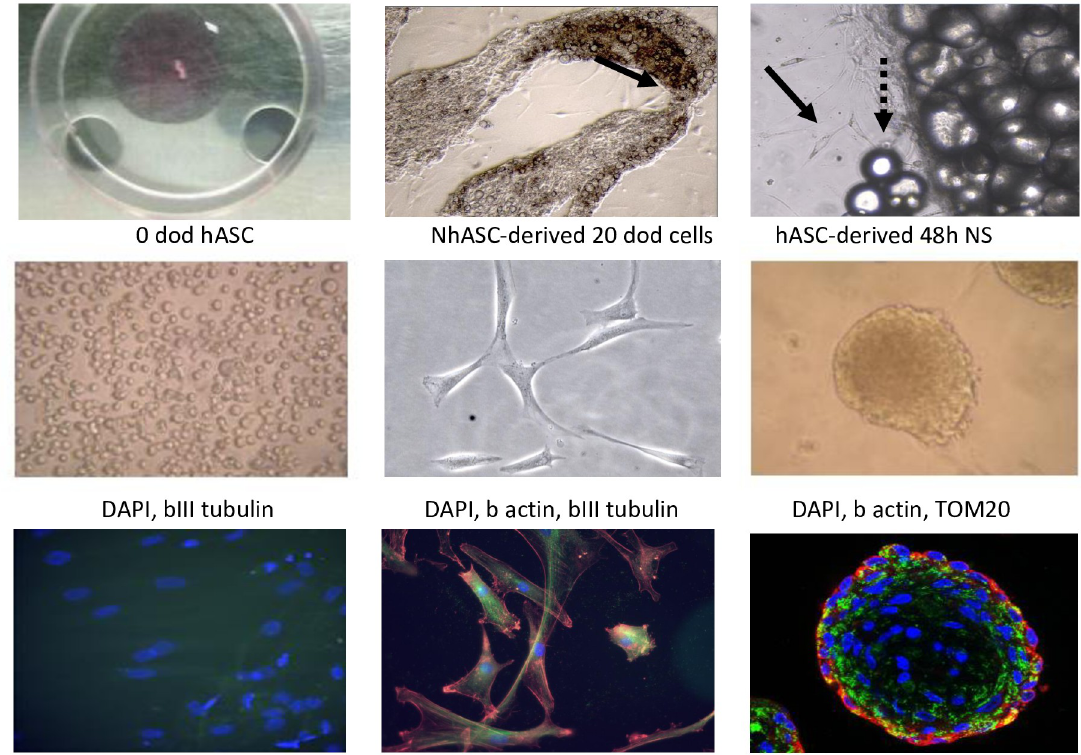
Fig 1. Representative images of hASC and NhASC. Upper panels: From left to right; first panel, forearm adipose tissue biopsy on a Petri dish prior to tissue disgregation; second and third panels, adipose tissue dissected fragments by optical microscopy (5x and 10x, respectively). Adipose tissue and scarce adipose cells generated from tissue explants. Black continuous arrow pointing adipose cells coming out from the explant. Black discontinuous arrow marking typical oil drops from adipose tissue samples. Middle panels: From left to right, first human adipose stem cells at 0h of induction with neurobasal differentiation media; second panel, human derived adipose stem cells after 20 days of differentiation in neurobasal differentiation media; third panel, neurosphere formation after 48 hours of induction. Dod, days of development (differentiation), hASCs, human adipose stem cells, NhASCs, neuronal-like adipose stem cells, NS, neurosphere. Bottom panels: From left to right; first, representative immunofluorescence images of forearm human adipose stem cells undifferentiated at basal timepoint conditions (blue DAPI); second, after 20 days of differentiation (blue DAPI, red b actin, green neuronal bIII tubulin) and third, after neurosphere formation (blue DAPI, red b actin, green TOM20). hASC, human adipose stem cells.